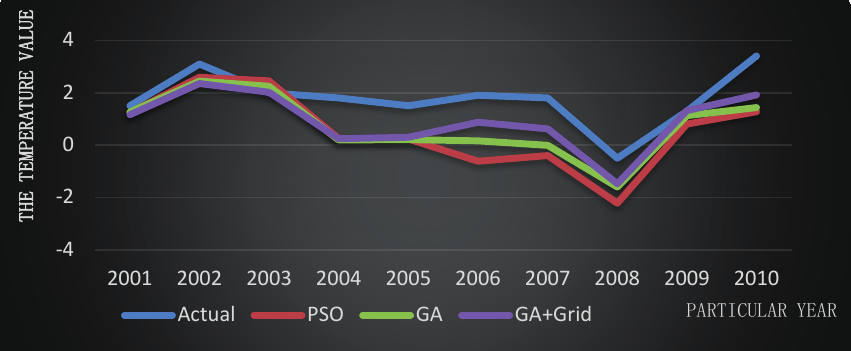
Fig. 4 Three kinds of optimization of the parameters of the trend line and method comparison